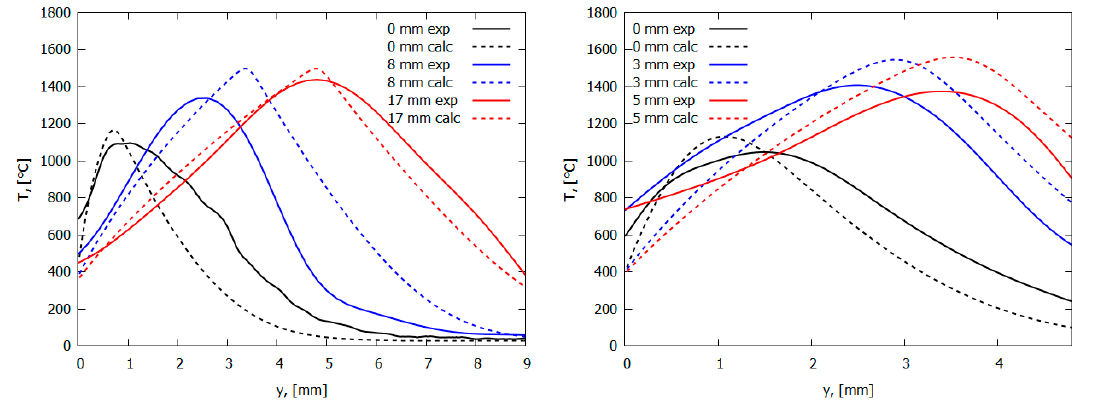
Figure 11. The temperature profiles in pure PMMA flame ( left ) and PMMA + 10%TPP flame ( right ) in the normal direction to the burning surface (legend shows the distance from the flame front). Solid lines—experiment; dashed lines—modeling.